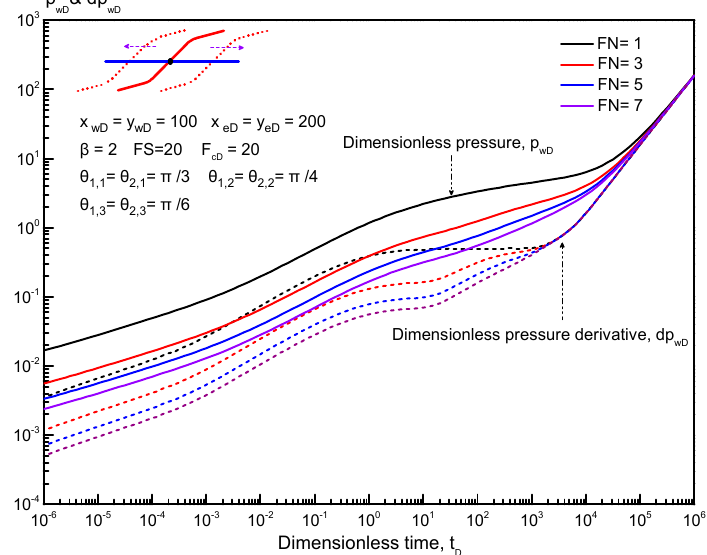
Figure 17. E ff ect of fracture number on pressure and the pressure Figure 17. Effect of fracture number on pressure and the pressure derivative. Figure 17. Effect of fracture number on pressure and the pressure derivative.